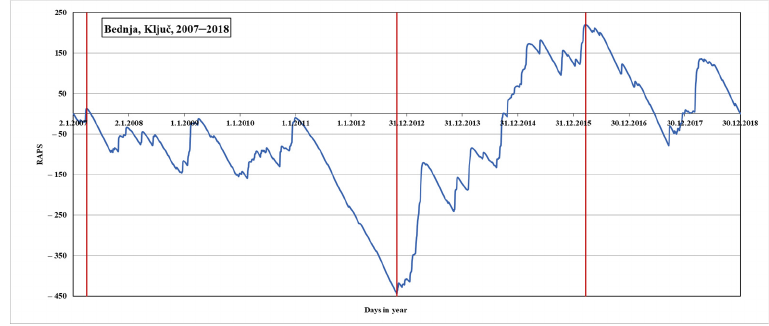
Figure 14. RAPS value on flow data from Klju č measurement station.